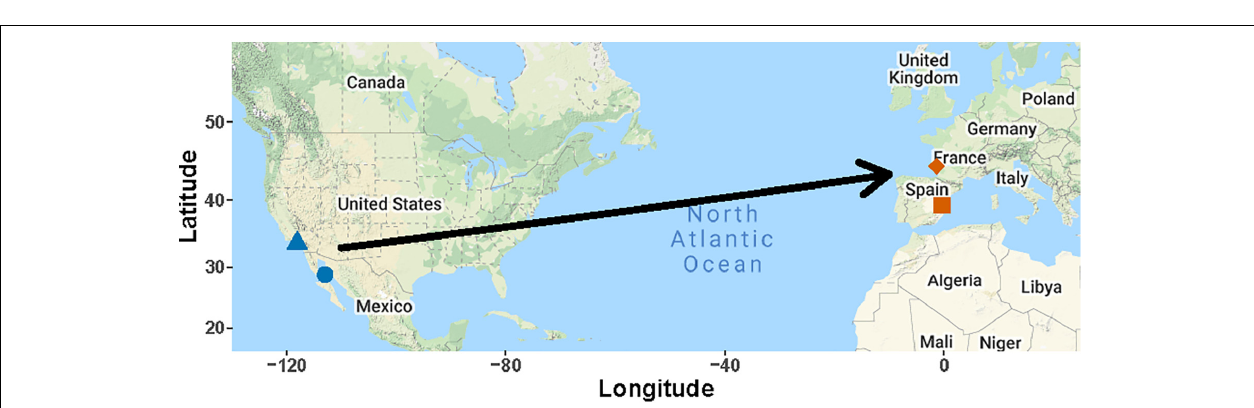
FIGURE 8 | Occurrence of vagrant elegant terns in Europe (Spain and France; number of individual vagrants). Note increase beginning in about 2000. Note the coincidence of the increase in vagrancy to both Europe and Eastern North America in about the year 2000, following major growth of Pacific colonies after 1995. Predicted values and confidence intervals shown.